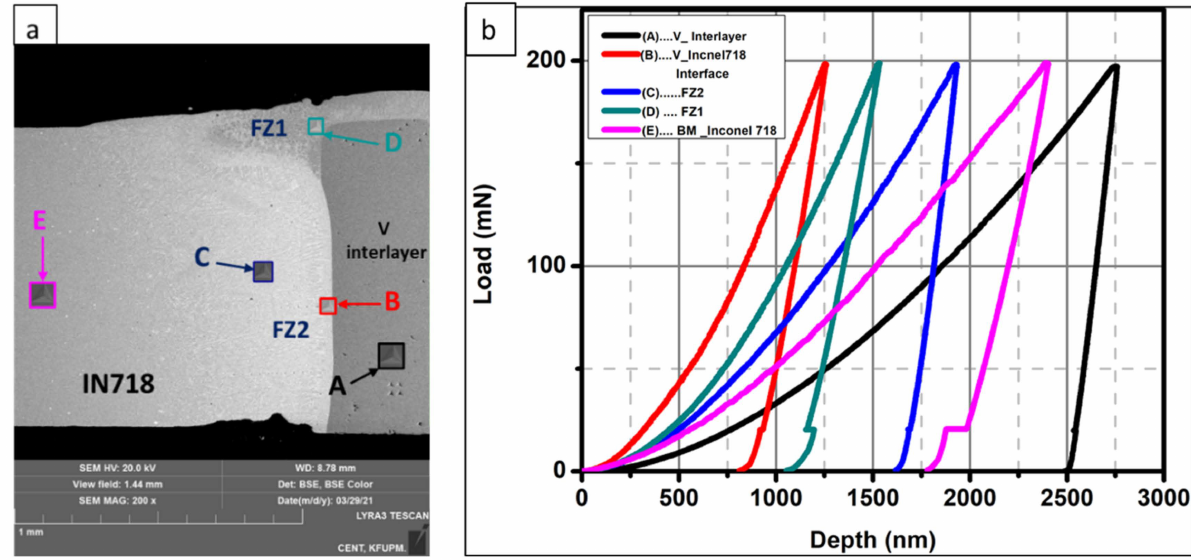
Figure 7. ( a ) SEM images showing nano indents on the V/IN718 side. ( b ) Nano-indentation results of load vs. depth curves for (N718) and the vanadium interlayer joint.